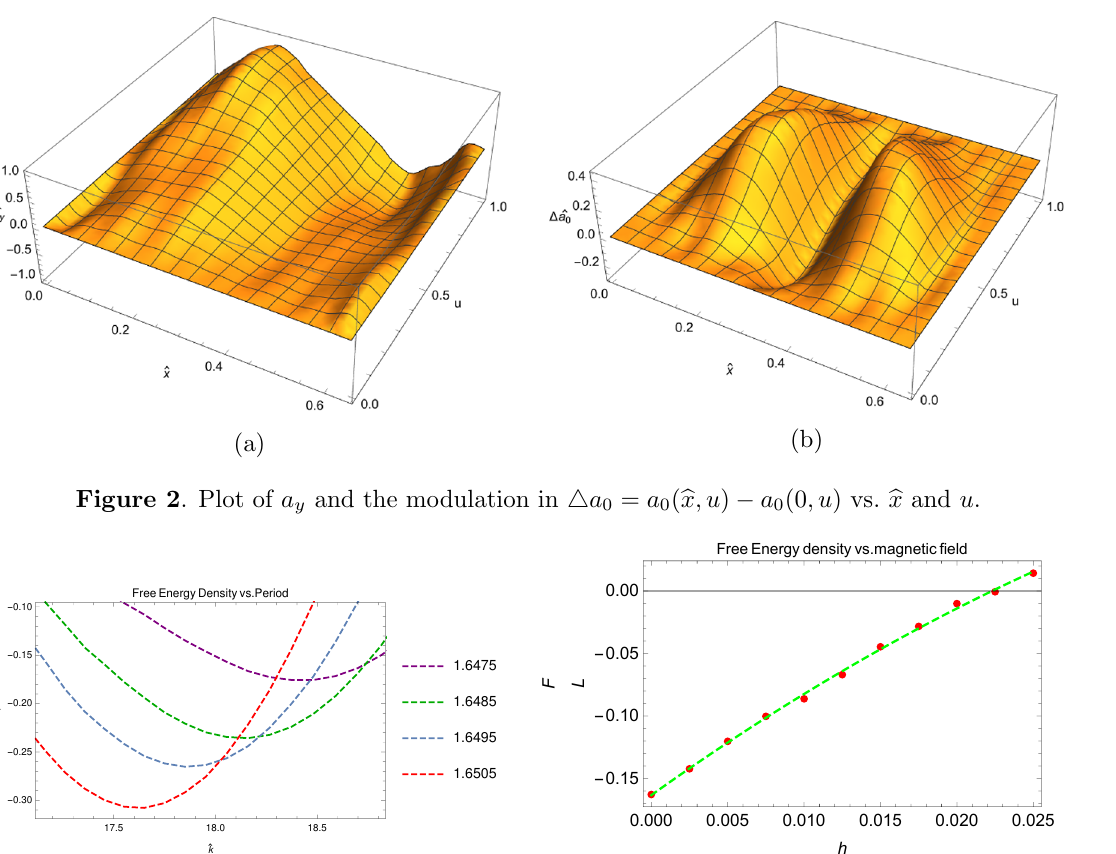
Figure 3a. Free energy density F=L vs. b k for di(cid:11)erent values of the chemical potential (cid:22) .